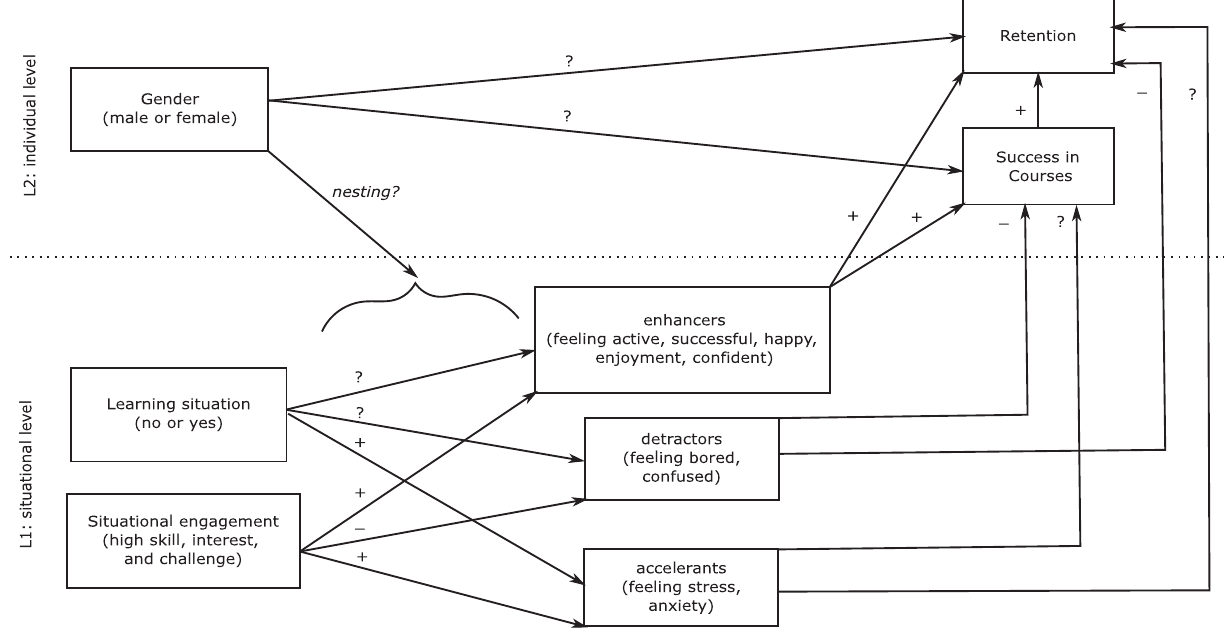
FIG. 2. Hypothesized connections of the chosen variables on two hierarchical levels. Plus sign ( þ ) indicates an expectation of a positive effect and minus sign ( − ) a negative one. Question mark (?) indicates an expected but not further specified effect. Situational engagement and being in a learning situation are expected to affect situational emotions, and these effects might be nested within gender. The effects of situational emotions cross the line between situational (within-person, L1) and individual (between-person, L2) levels, and are expected to affect success in courses as well as retention. Gender could also have direct effects to emotions, success in courses, and